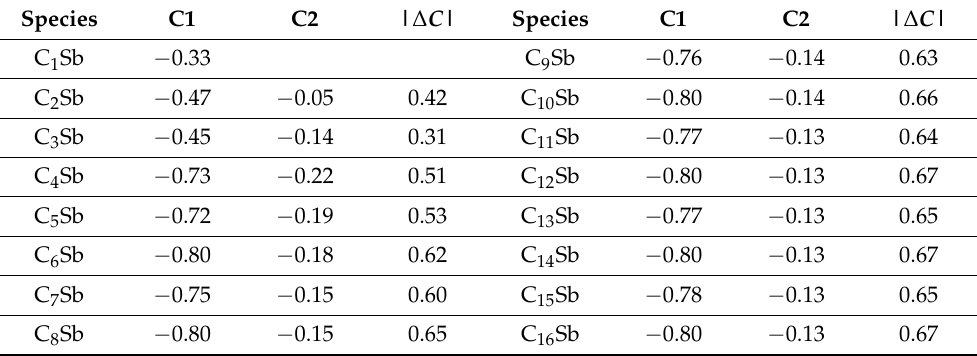
Table 9. The charge population and charge difference ( | ∆ C | ) of terminal carbon atoms which are adjacent antimony (C1) and far away from antimony